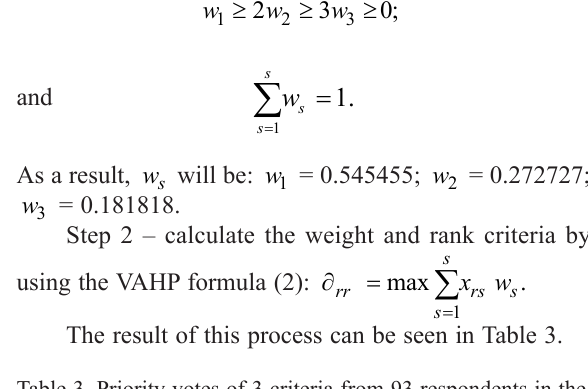
Table 3. Priority votes of 3 criteria from 93 respondents in the survey